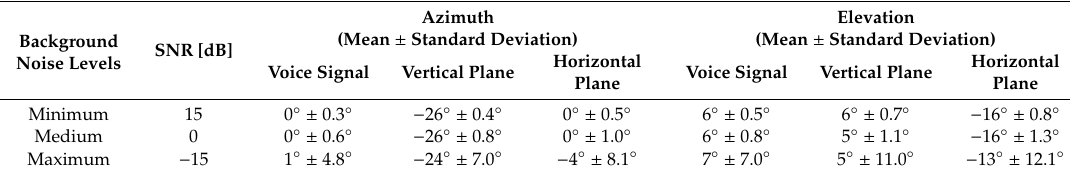
Table 4. Accuracy data obtained for setup 3 tests, using a voice